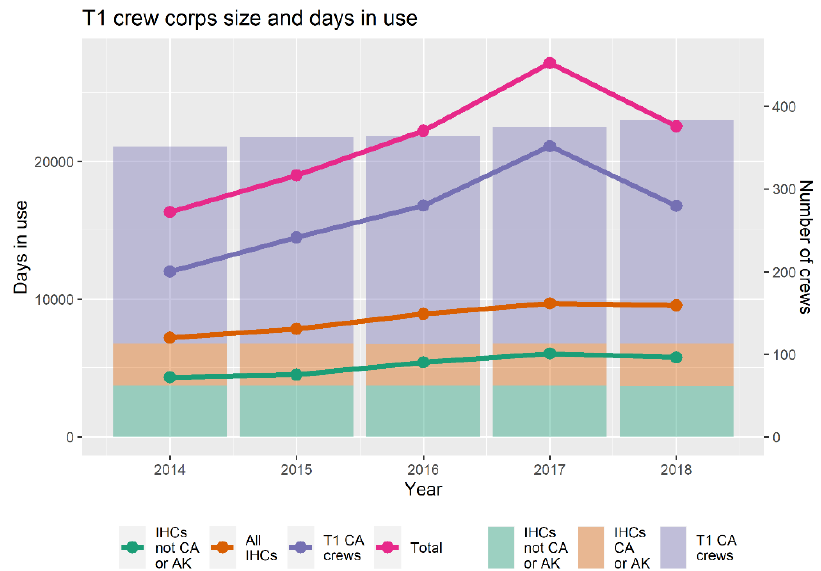
Figure 2. T1 crew corps size and use over time. Corps size depicted by crew type (Interagency Hotshot Crew not from California or Alaska, Interagency Hotshot Crew from California or Alaska, or T1 crew from California that is not an Interagency Hotshot Crew); corps size and number of days of crew usage data obtained from the Resource Ordering and Status System (ROSS). The T1 California crew hours include the California Interagency Hotshot Crews (IHCs).